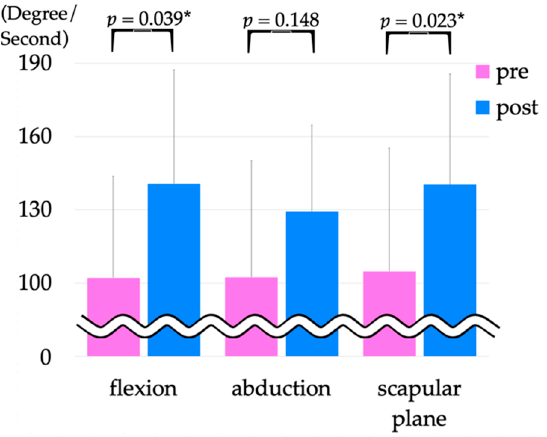
Figure 6. Motion analysis of raising the affected side of the upper limb in the standing position without HAL. * p < 0.05. HAL, hybrid assistive limb. without HAL. * p < 0.05. HAL, hybrid assistive limb.